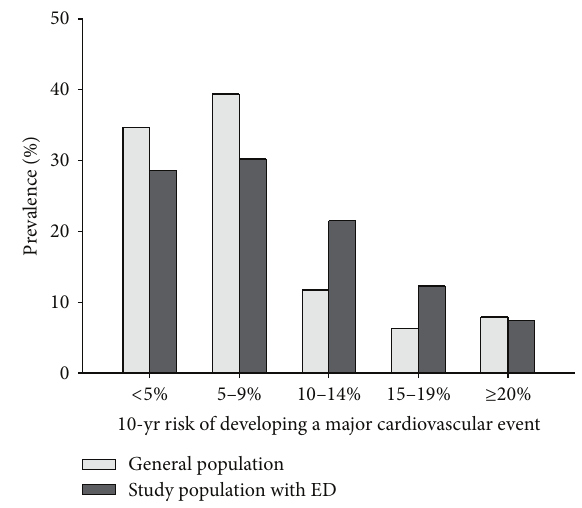
Figure 3: Distribution of CV risk in the general population and in the ED